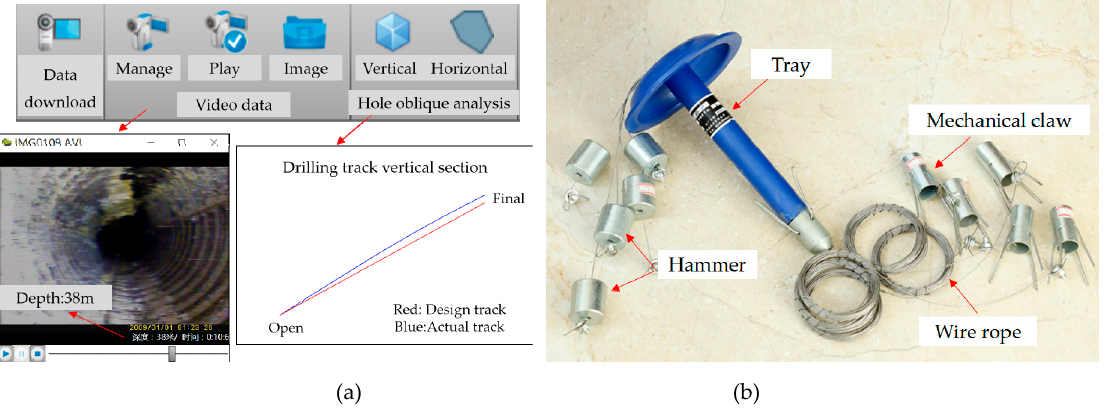
Figure 5. Field measurement equipment: (a) Drilling peep; (b) Multi-point displacement.